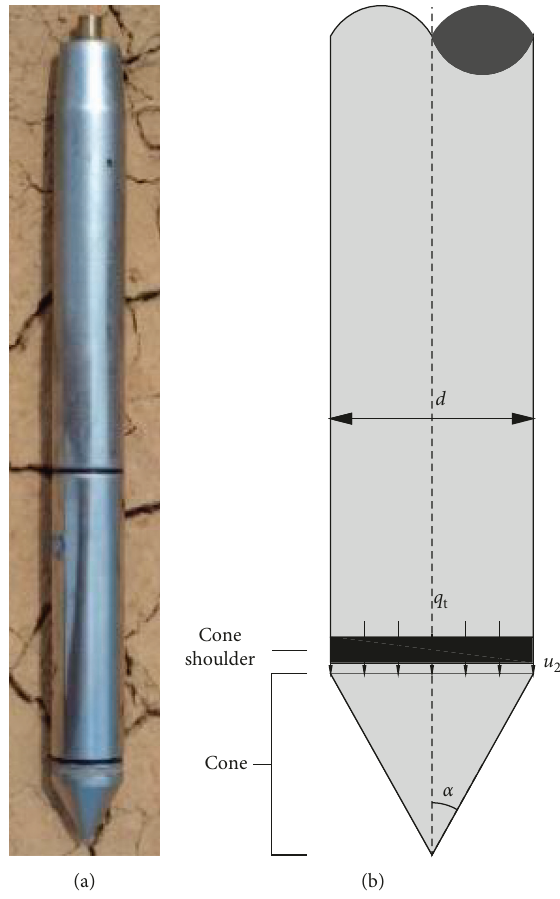
Figure 1: (a) CPTU probe entity and (b) schematic